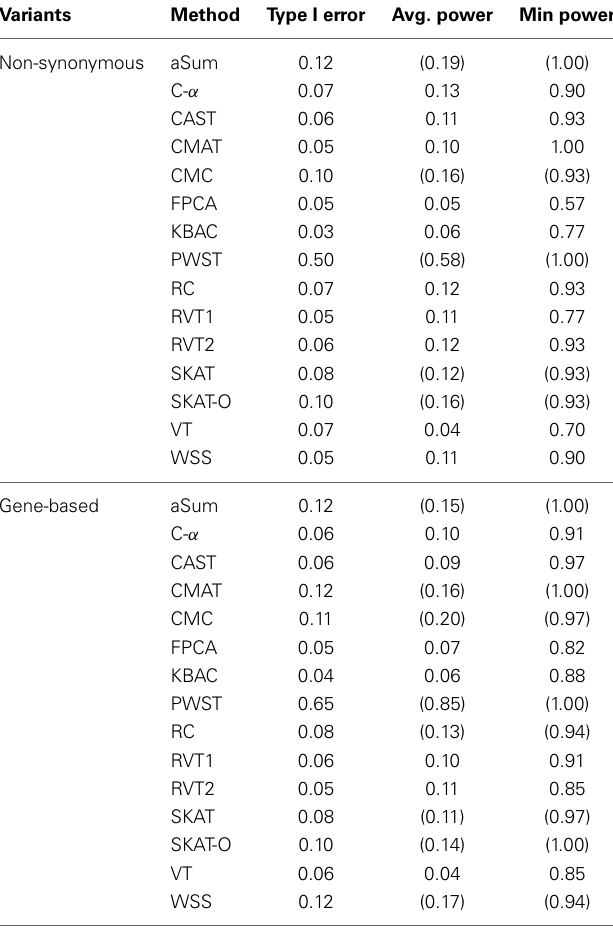
Table 3 | p -values from the association analysis between methotrexate clearence and the SLCO1B1 gene in patients with acute lymphoblastic